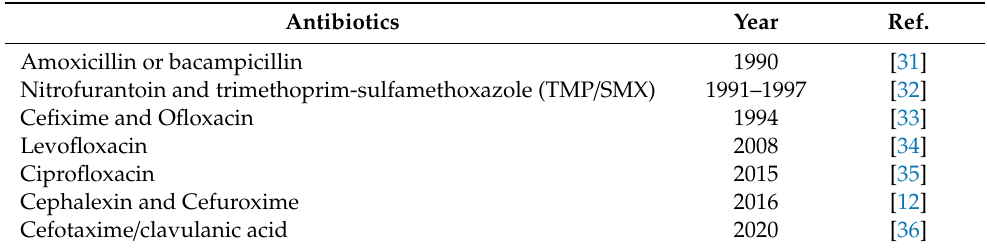
Table 2. Antibiotics prescribed for the treatment of E. coli